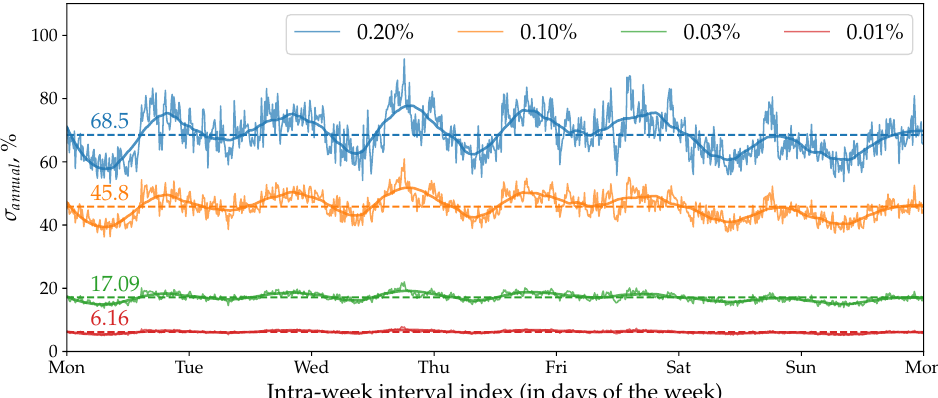
Figure 12. Instantaneous volatility seasonality of BTC/USD exchange rate computed using the directional-change approach (Equation (19)) and four different thresholds. Applied thresholds, from top to bottom: δ = 0.20%,0.10%,0.03%,0.01% . The dark solid curves approximate the Bitcoin { } seasonality patterns using the Savitzky–Golay filter (number of points in the window is 101, order of the polynomial is 2). Bin size T = 10 min was chosen in all cases (1008 bins in a week). Dashed lines and the numbers over them represent the average level of each seasonality pattern across a